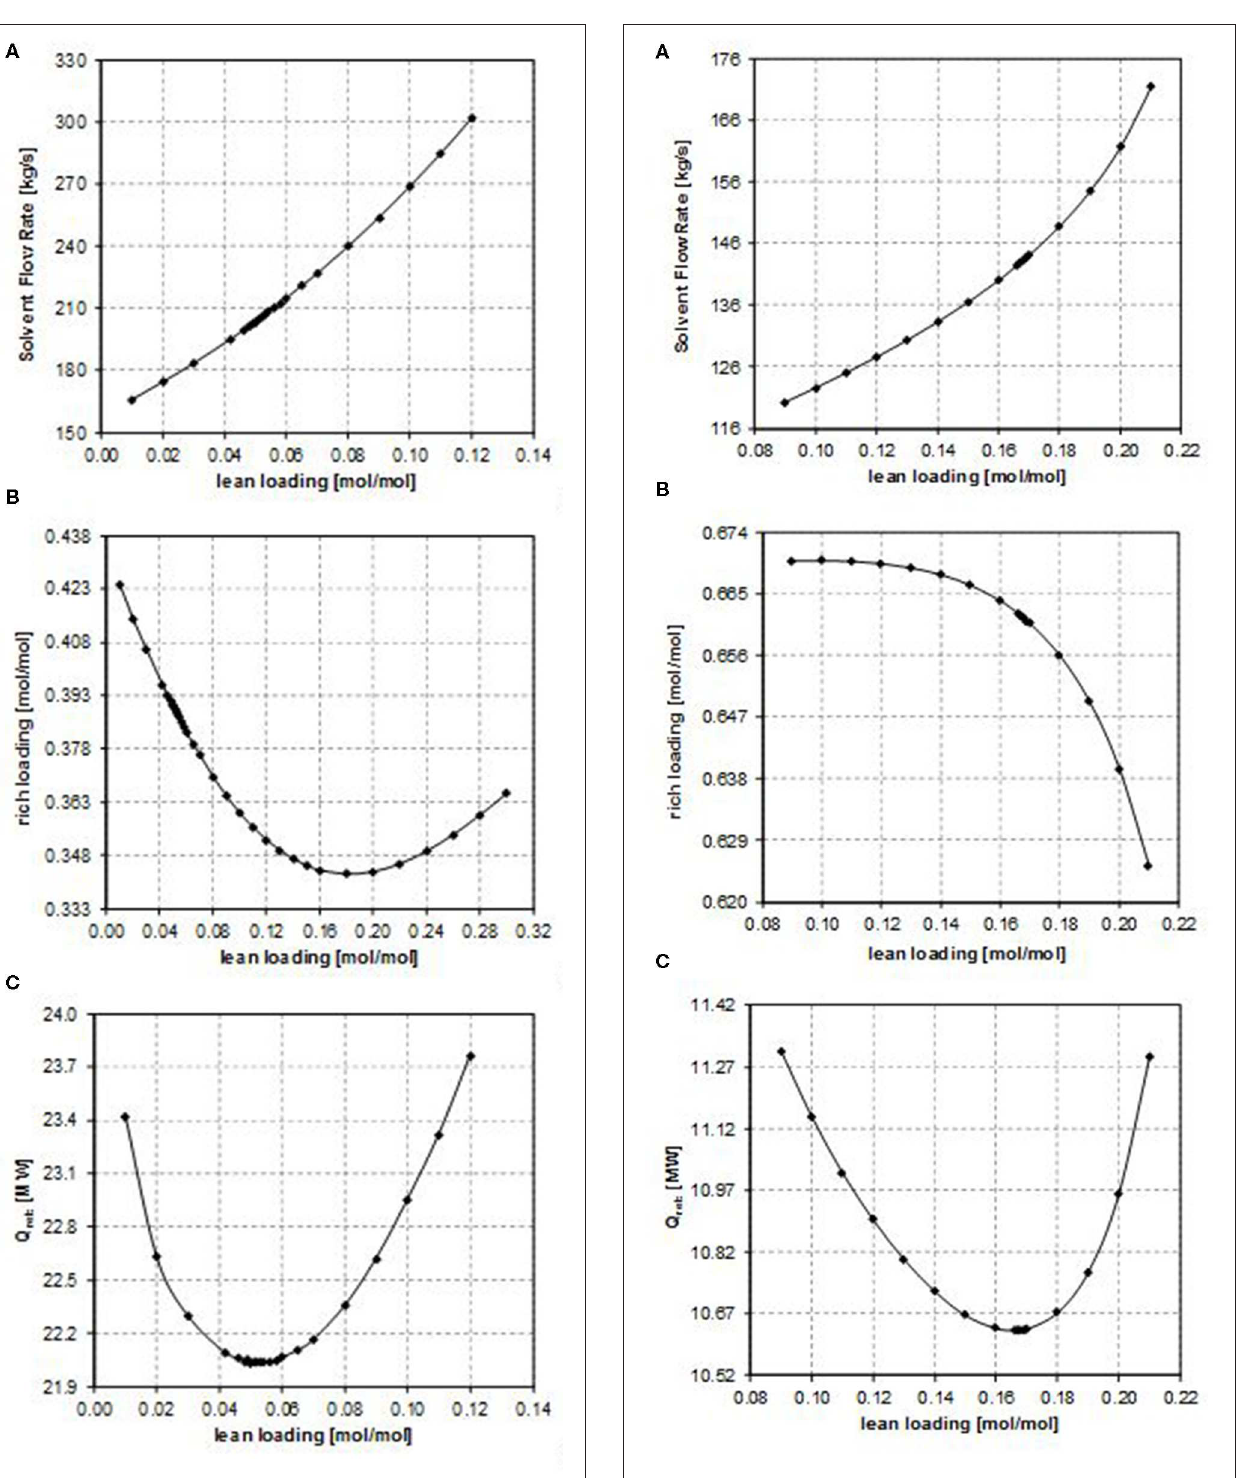
Frontiers in Energy Research |